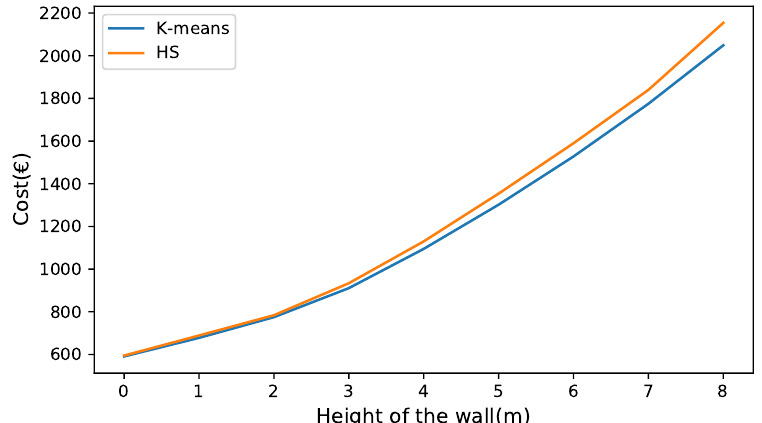
Figure 11. Comparison between the best solutions obtained by the k-means and HS algorithms in cost optimization.